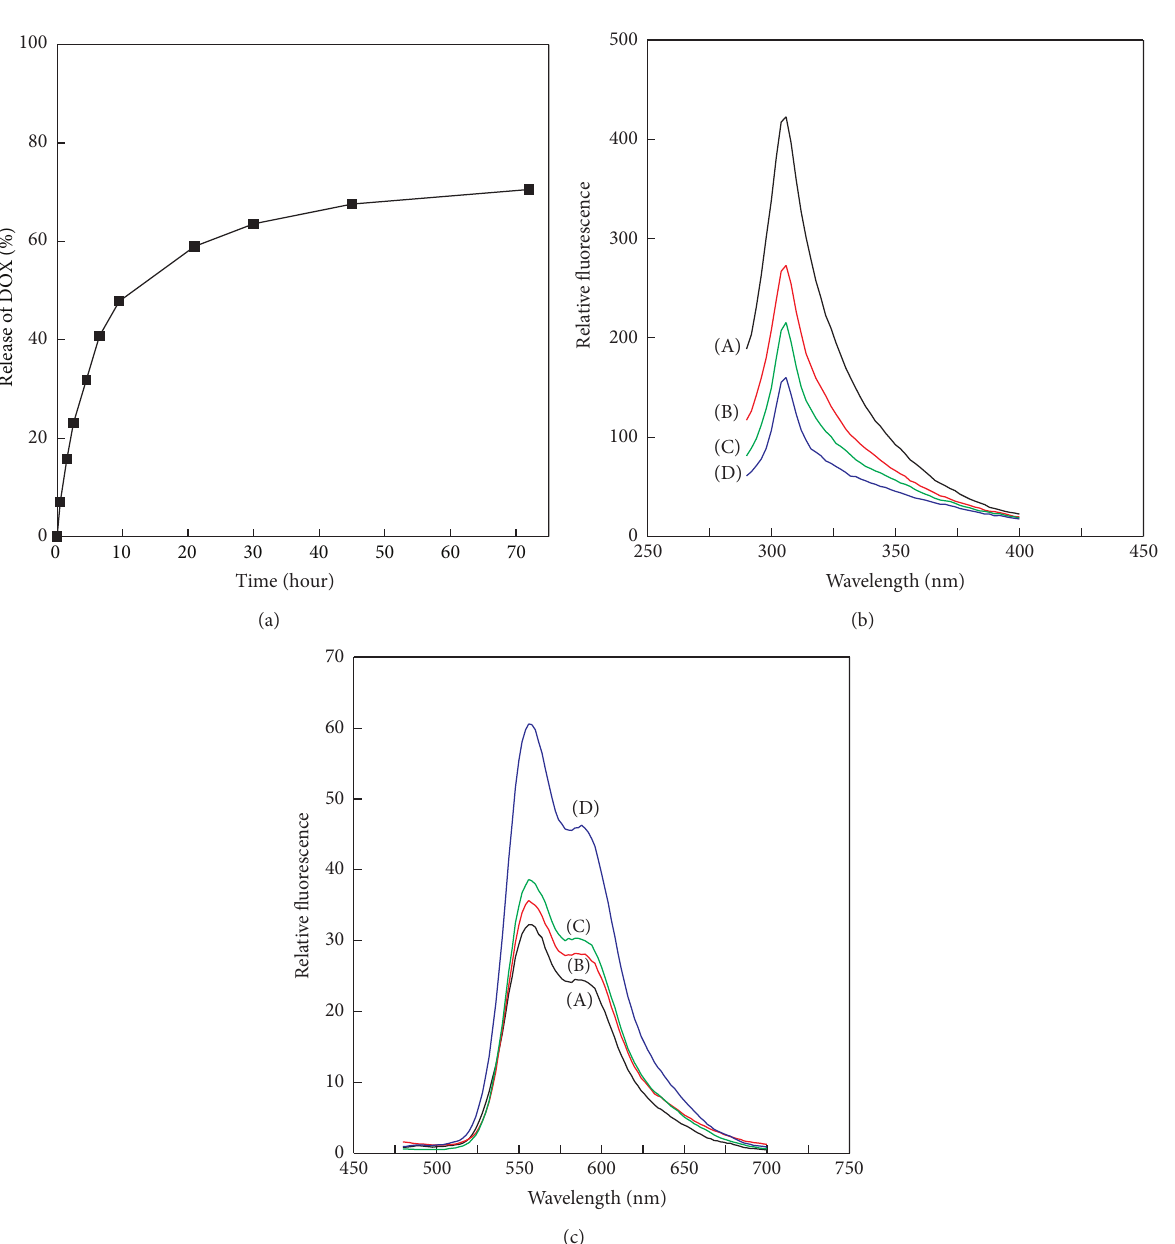
Figure 5: (a) Release profile of DOX from MFMSNs-HP (pH = 7.4). (b) Fluorescence spectra of bFGF in the absence/presence of MFMSNs- HP: free bFGF (2 𝜇 M, 1mL) (A), bFGF (2 𝜇 M) + 10, 20, and 30 𝜇 L of MFMSNs-HP (10mg mL −1 ) (B, C, D). (c) Fluorescence spectra of DOX in the absence/presence of bFGF: free DOX (1nmol, 1mL (A), 2 nmol, 1mL (D)), DOX-loaded MFMSNs-HP (0.5 mgmL −1 , 1mL) + 10 and 20 𝜇 L of bFGF (100 𝜇 M) (B,